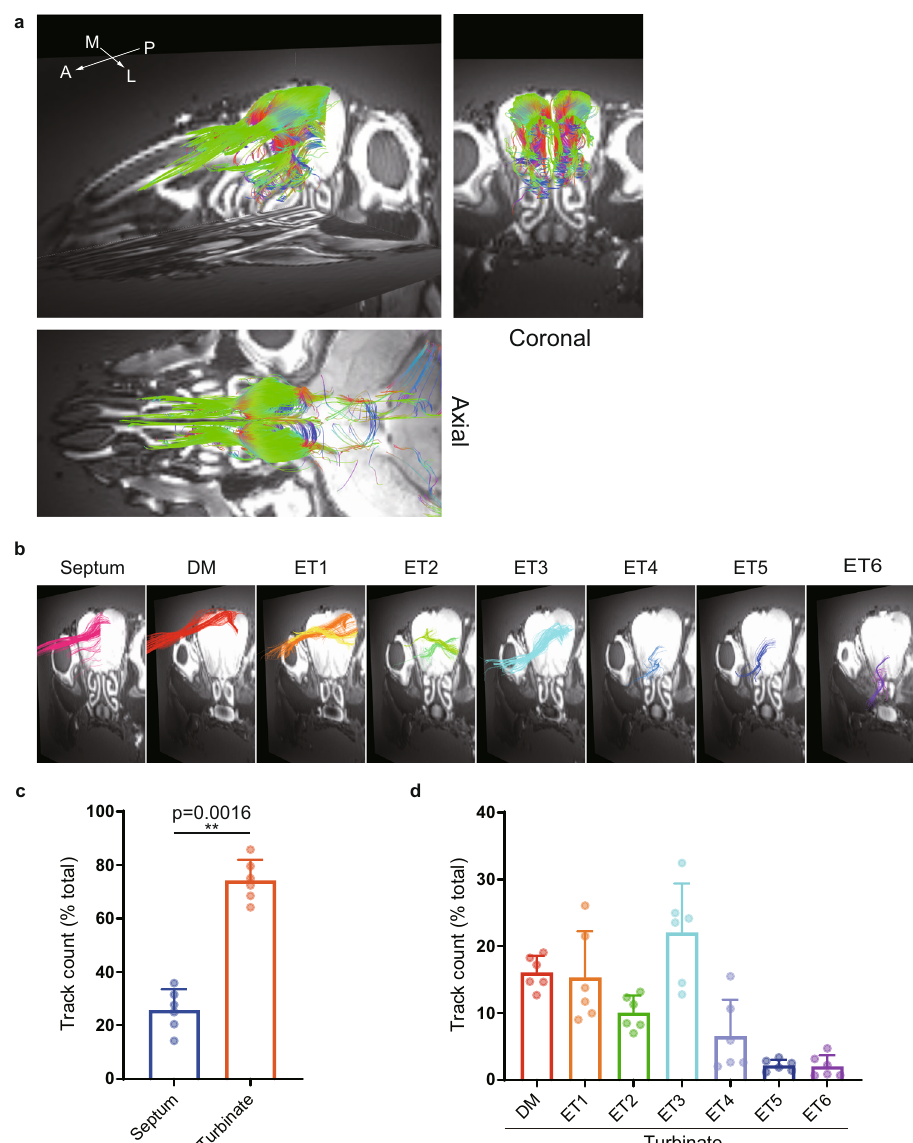
Fig. 1 The distribution of mouse olfactory nerves depicted by diffusion tensor tractography (DTT). a DTT was performed using the whole skull of a mouse. The reconstructed three-dimensional images show oblique-sagittal, coronal and axial views. The colored fi bers were visualized with DTT, and b0 images were used as the background images. The olfactory bulbs were selected as the region of interest (ROI) so that the depicted fi bers re fl ected the neurons that projected from the nasal cavity to the olfactory bulbs. The fi bers are color-coded according to their directionality: anterior-posterior axis, green; medial-lateral axis, blue; and superior-inferior axis, red. A anterior, L lateral, M medial, P posterior. b Oblique-sagittal views of the fi ber tracts projecting from the main anatomical structures in the nasal cavity. The nerve tracts identi fi ed by DTT were color-coded according to the structure selected as the ROI (septum, dorsal meatus or each of the six ethmoturbinates). Each b0 image represents a coronal cross-section of the oblique-sagittal image in Fig. 1a. DM dorsal meatus, ET ethmoturbinate. c The track counting function of TrackVis was used to measure the density of fi bers distributed in the septum and turbinates. Each value is expressed as the percentage of the total track counts. Bars show the mean and standard deviation. Individual data points are shown in dots ( n = 6; 6 nasal cavities from 3 biologically independent specimens). ** p < 0.01. d The percentage of all track counts of the fi bers distributed to the dorsal meatus and each of the six turbinates (ET1 – 6). Bars show the mean and standard deviation. Individual data points are shown in dots ( n = 6; 6 nasal cavities from 3 biologically independent